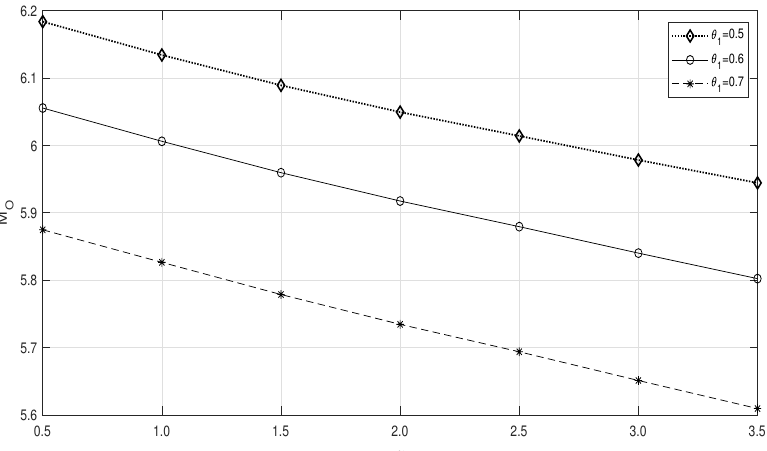
Figure 3. Mean number of customers in the orbit on θ 1 vs. γ